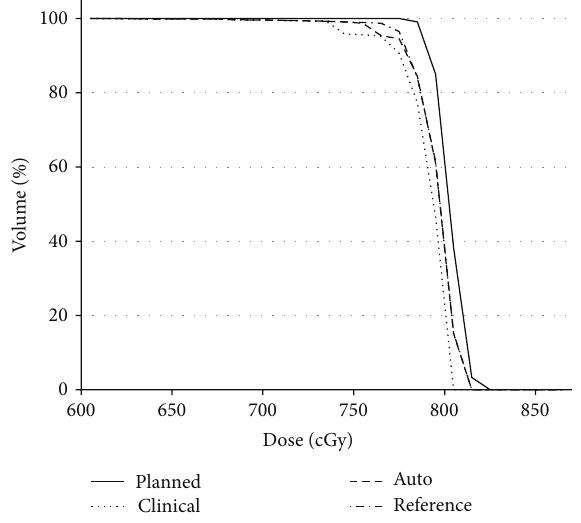
Figure 12: DVHs for a boost portion. The planned dose was scaled to four